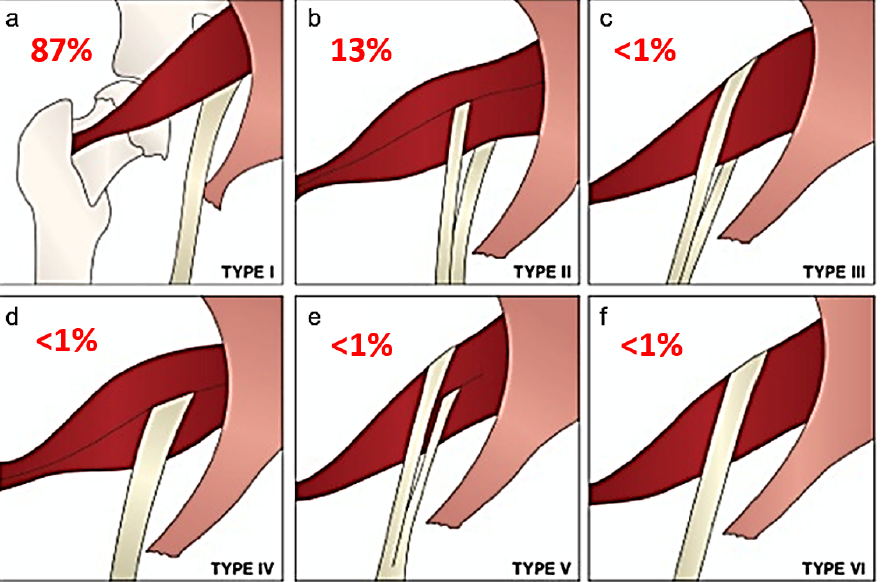
Figure 1. Beaton and Anson classification of different anatomical relationships between the sciatic nerve and piriformis muscle and their estimated prevalence. ( a ) Type 1: undivided sciatic nerve passing anterior and below the piriformis. ( b ) Type 2: common peroneal nerve component piercing a bifid piriformis, tibial component running in normal position anterior and inferior to piriformis. ( c ) Type 3: one division posterior to and the other anterior to the piriformis. ( d ) Type 4: undivided sciatic nerve piercing bifid piriformis. ( e ) Type 5: one division through and the other posterior to the piriformis. ( f ) Type 6: undivided nerve posterior to piriformis. Figure adapted with permission from Varenika et al.